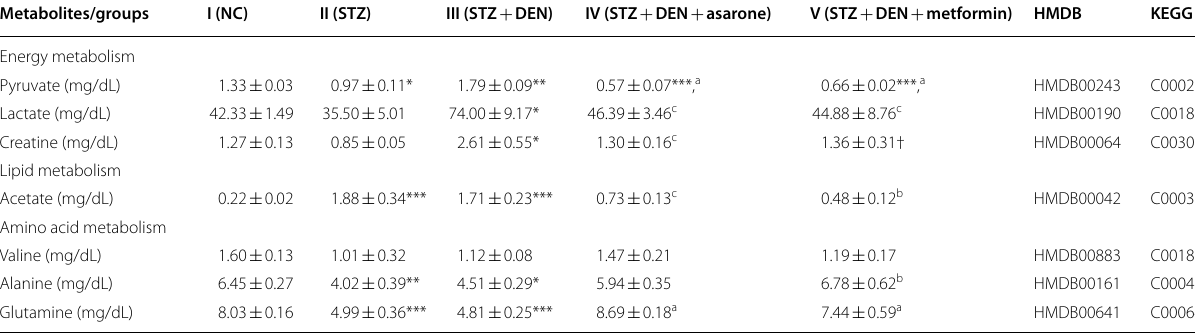
Table 3 Effect of asarone and metformin on different serum metabolite levels